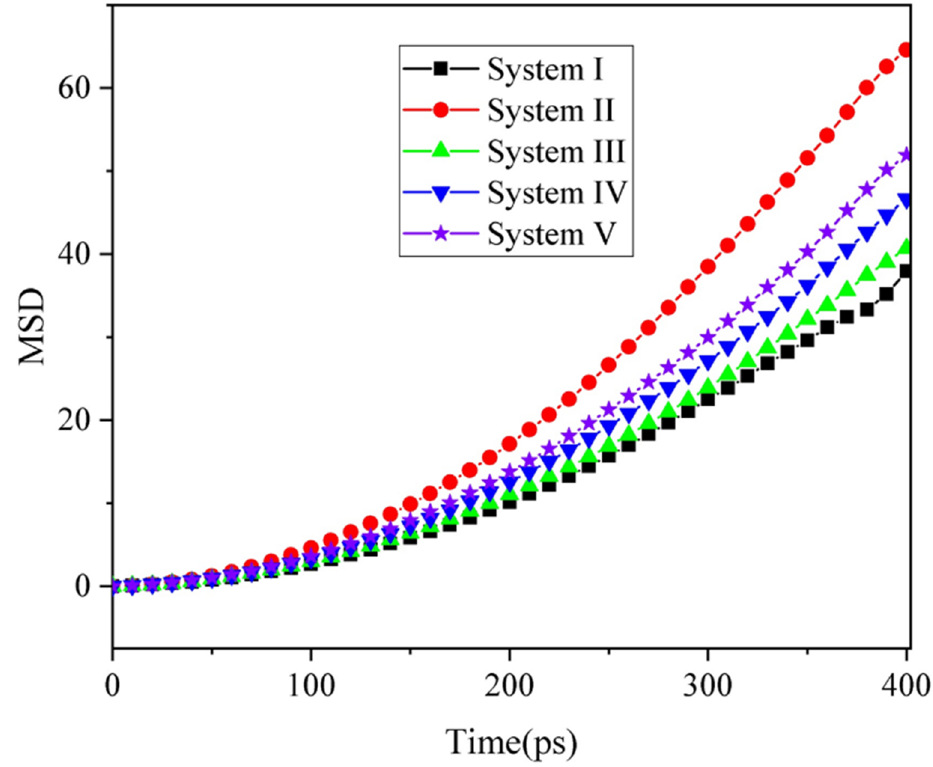
Figure 7. Mean square displacements of SDS and asphaltene molecules in five systems.